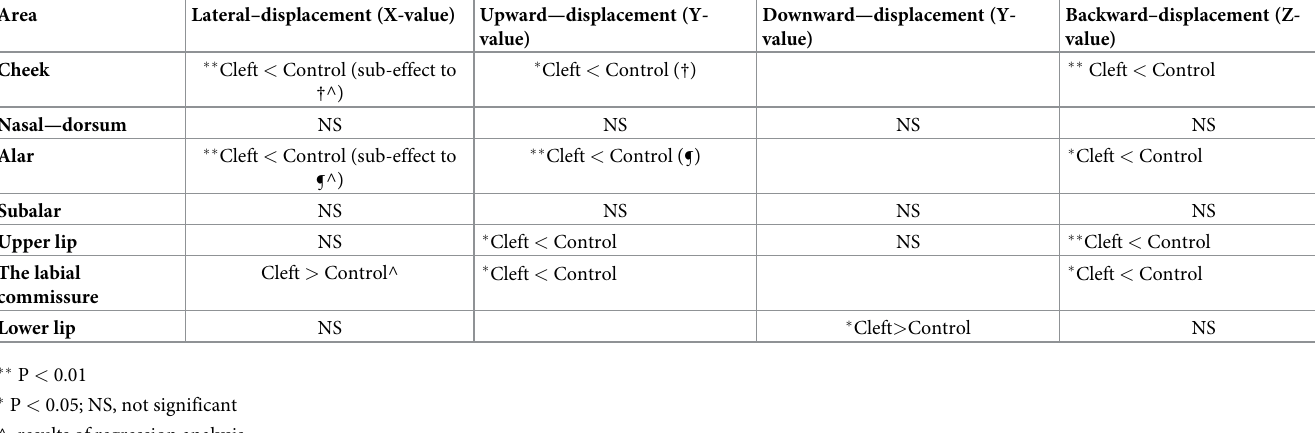
Table 2. Summary of the displacement while smiling in the two groups on the non-cleft side. Area